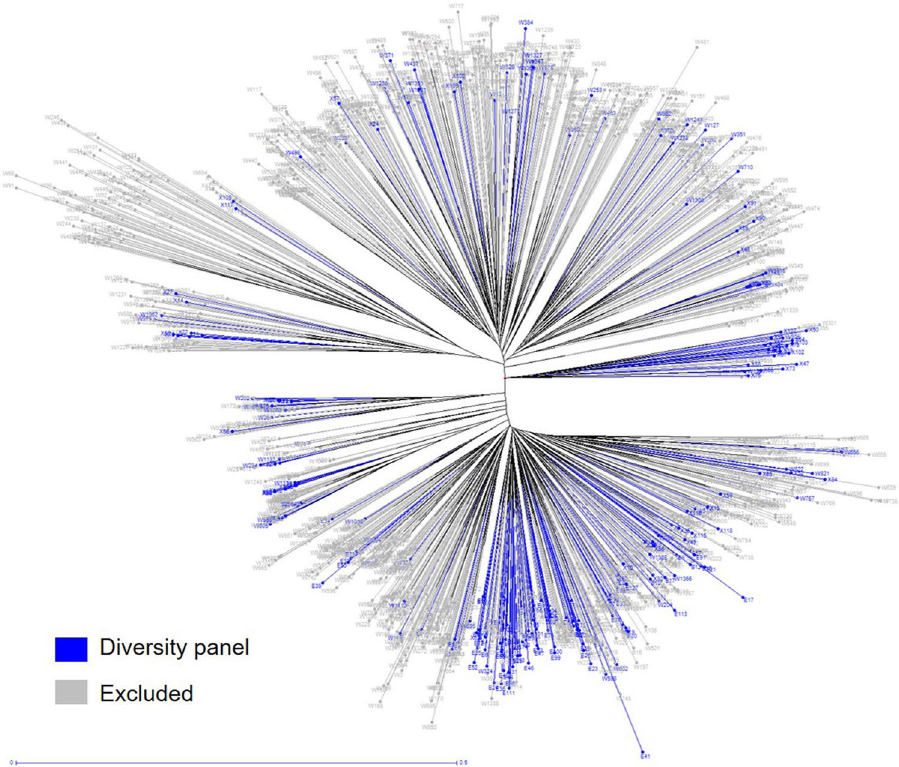
Figure 5. Neighbor-joining tree showing 309-clone diversity panel. Two-hundred thirty-eight clones (blue) were selected based on maximum length subtree program of DARwin with representation from different subclusters. Fifty-seven Louisiana commercial cultivars and 14 F 1 clones from basic base broadening program were included to maximize representation of Louisiana clones and minimize representation of Saccharum spontaneum